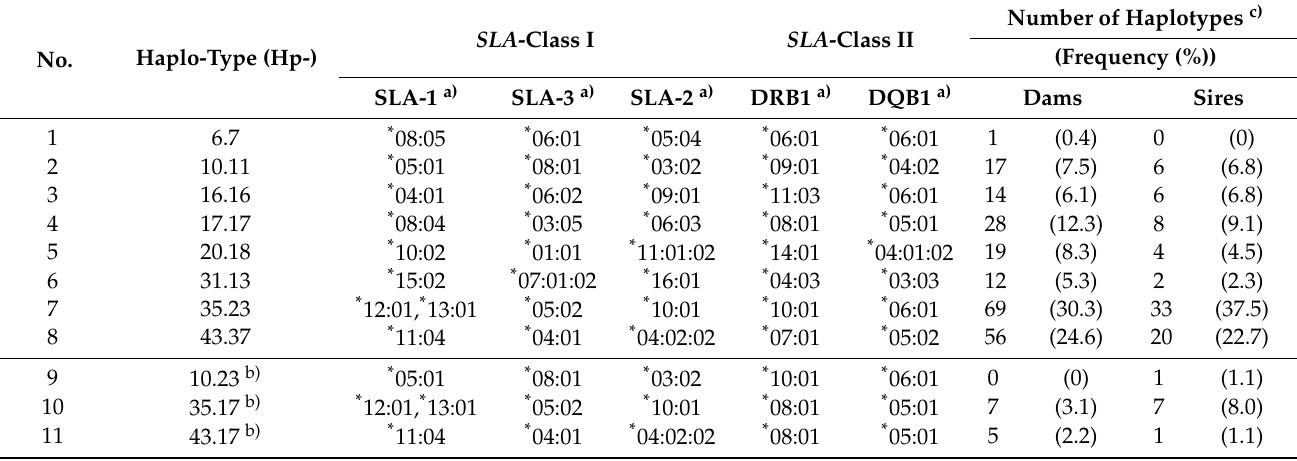
Table 1. SLA -class I and II genotypes and number of SLA haplotypes in